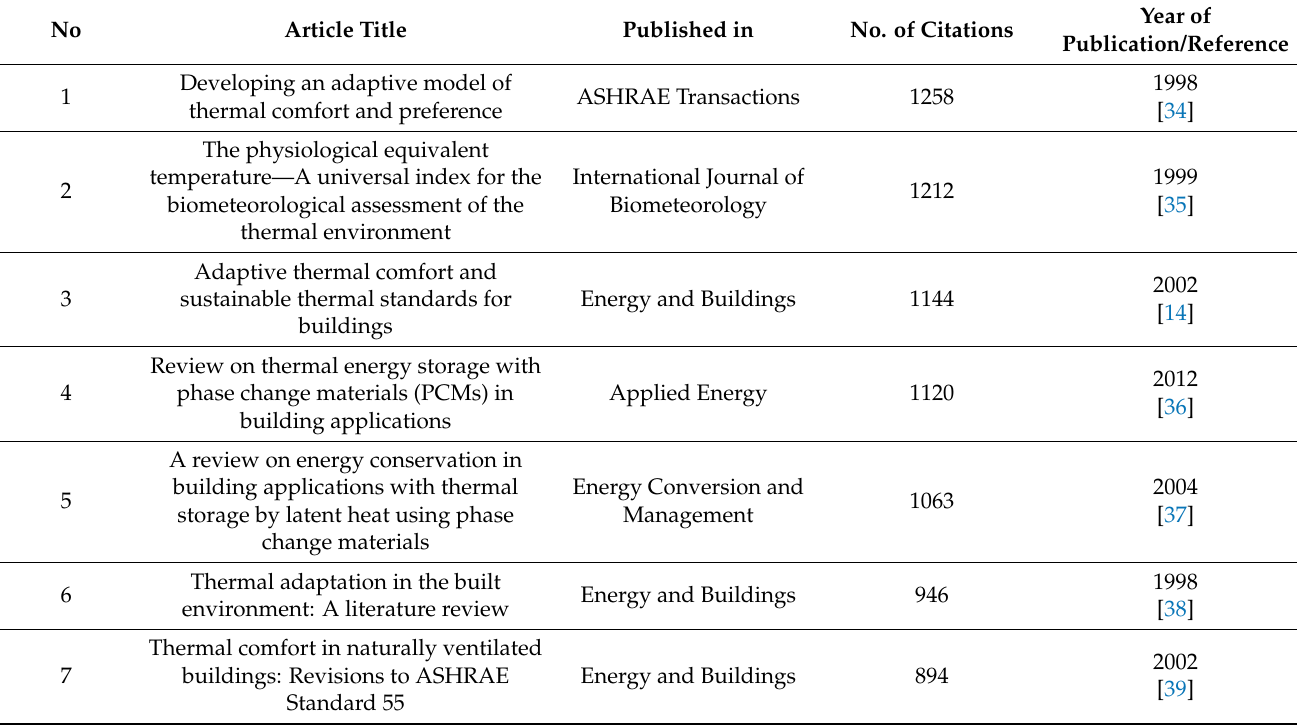
Table 2. Top 10 documents regarding thermal comfort found in Scopus based on the number of citations.